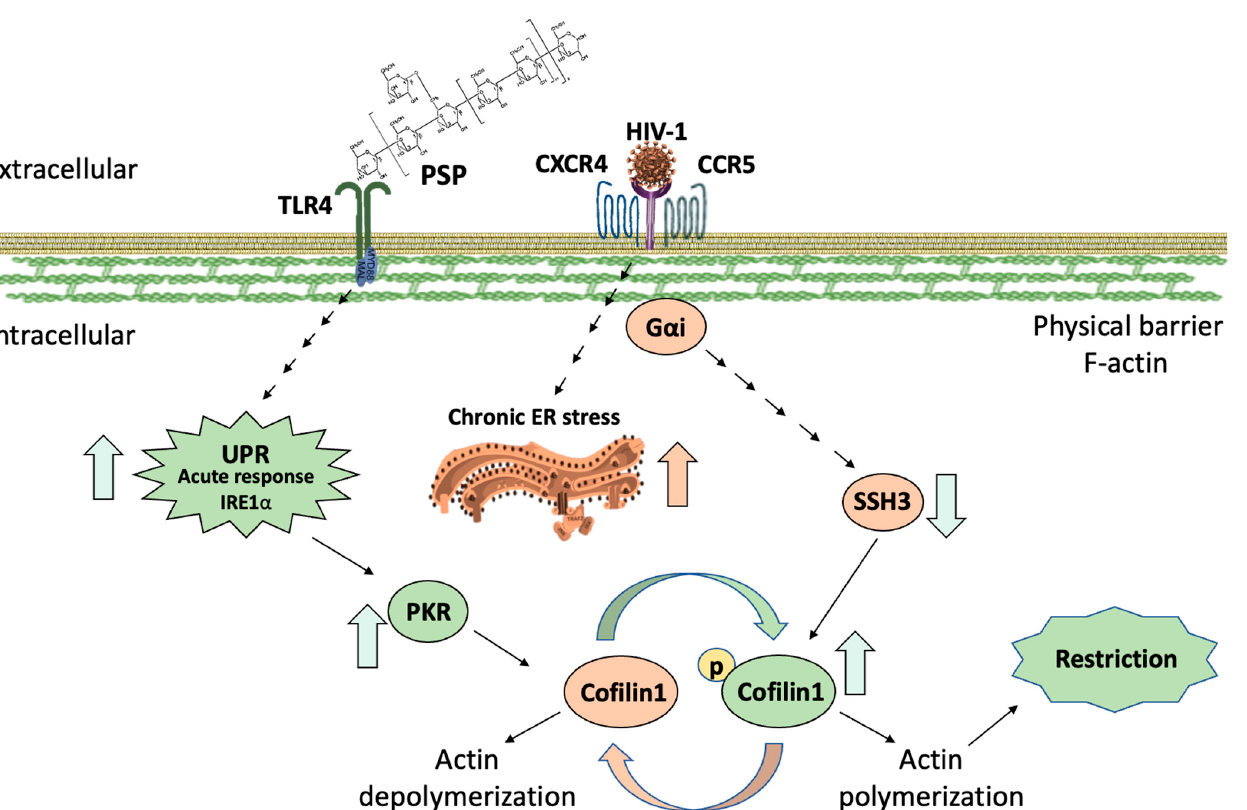
Figure 8. Model depicting PSP signaling through a UPR/IFN-induced pathway. HIV-1 infection results in a chronic ER stress response, while simultaneously dephosphorylating cofilin-1 through SSH3 phosphatase. This results in actin depolymerization for viral entry. Prior to infection, PSP treatment induces actin polymerization via an acute UPR. PKR mediates downstream phosphorylation of IRE1 α signals and reverses HIV-induced actin remodeling while infection persists. Legend colors: Green—PSP-mediated signaling and events. Cream- HIV-downstream pathways.